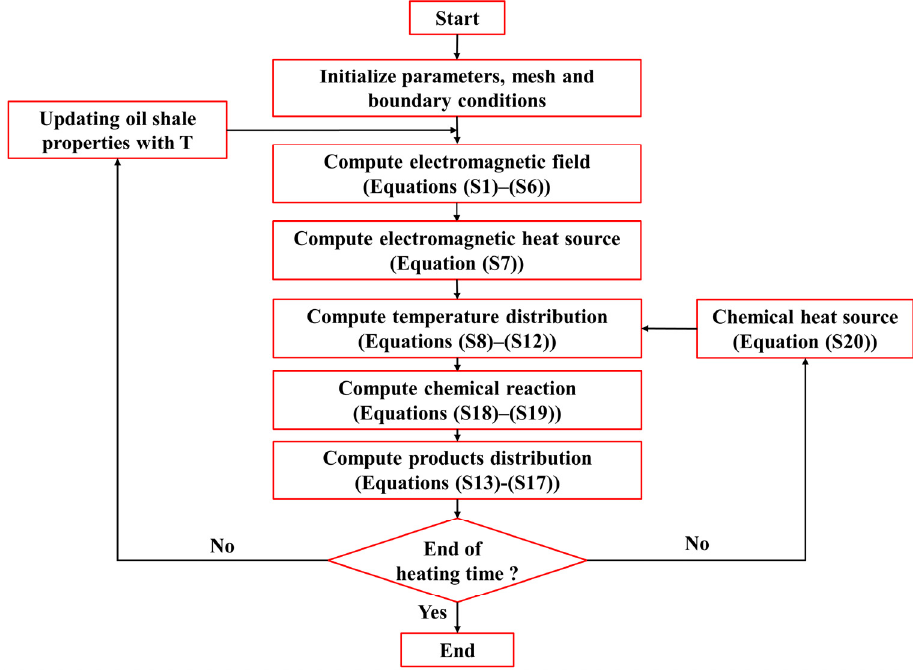
Figure 3. Calculation process for oil shale retorting under microwave heating.